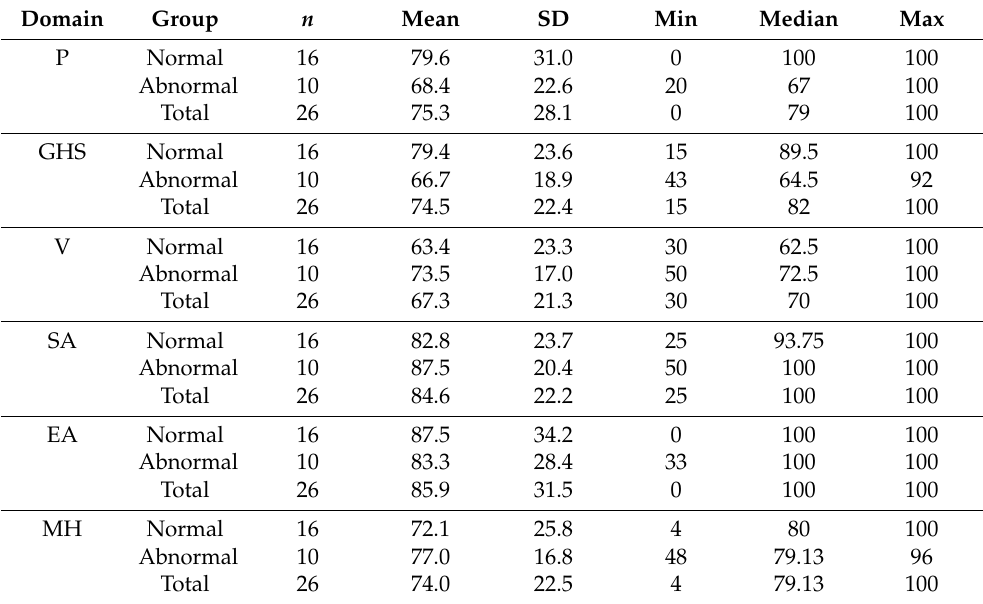
Table 3. Descriptive statistics for scores in the SF-36 domains for the Normal and Abnormal BAEPs groups.